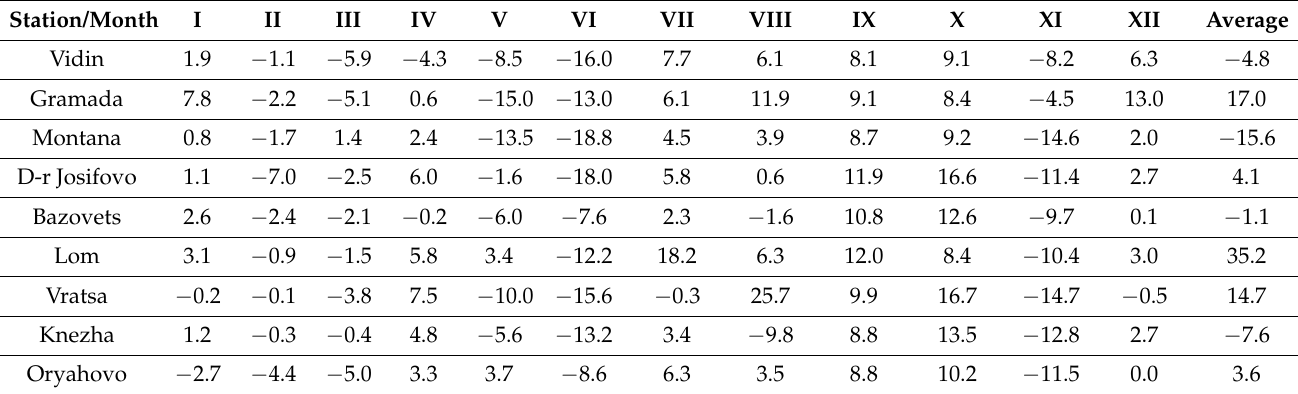
Table 12. Average monthly sums of rainfall deviations in northwestern Bulgaria in the period